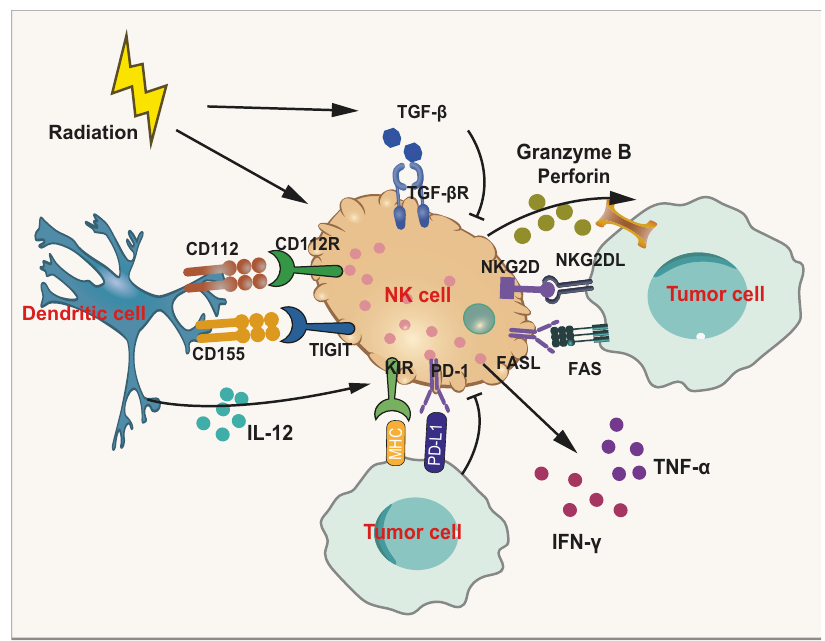
Fig. 8 Immunomodulatory effect of radiation on NK cells. On the one hand, radiation inhibits NK cells through increasing TGF- β . Moreover, the exposure of MHC-I molecules on the surface of tumor cells caused by radiation also inactivates NK cells through KIR. In addition, radiation induces the upregulation of activating receptors NKG2D and NKG2D ligands (NKG2DLs) to enhance the function of NK cells via granzyme B and perforin, FAS and FAS ligand and ADCC. Parts of this fi gure were drawn with aid of Servier Medical Art (http://www.servier.com),